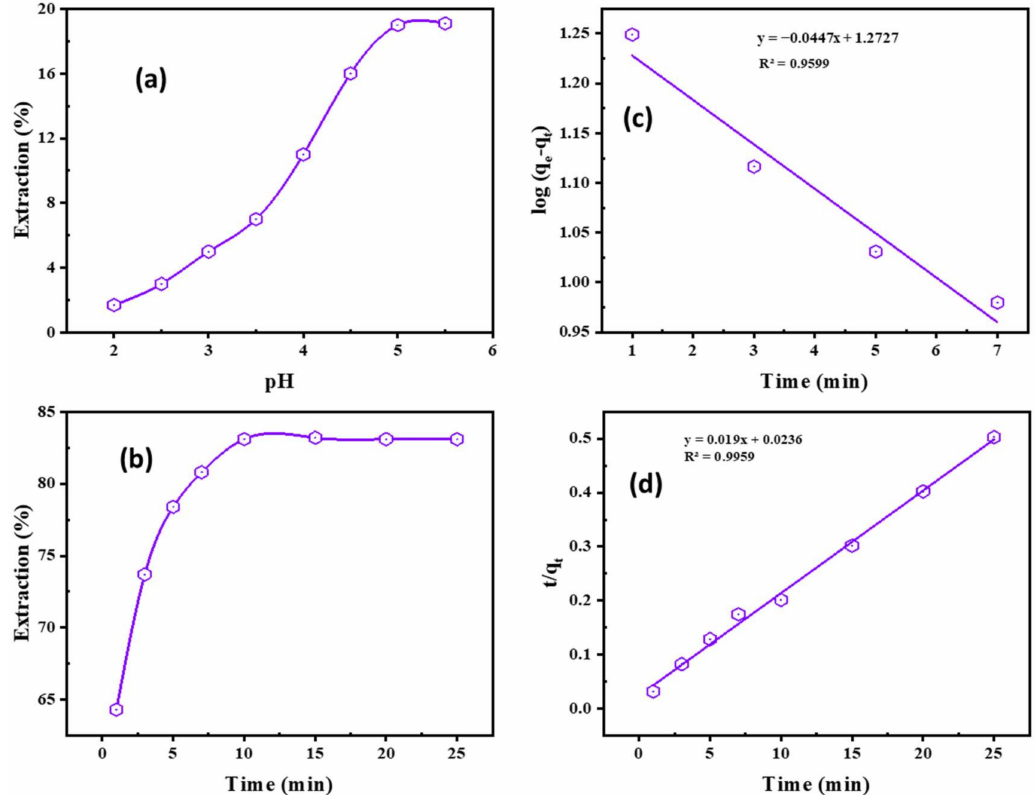
Figure 1. ( a ) Impacts of pH (0.1 M Na 2 SO 4 , 0.02 M Adogen 464, 5 min, O:A 1:1, 25 ◦ C); ( b ) equili- bration time on Cd 2+ extraction (0.1 M Na 2 SO 4 , pH 5.0, 0.02 M Adogen 464, O:A 1:1, 25 ◦ C); ( c ) The pseudo-1st-order; ( d ) pseudo-2nd-order modeling of Cd 2+ extraction by Adogen